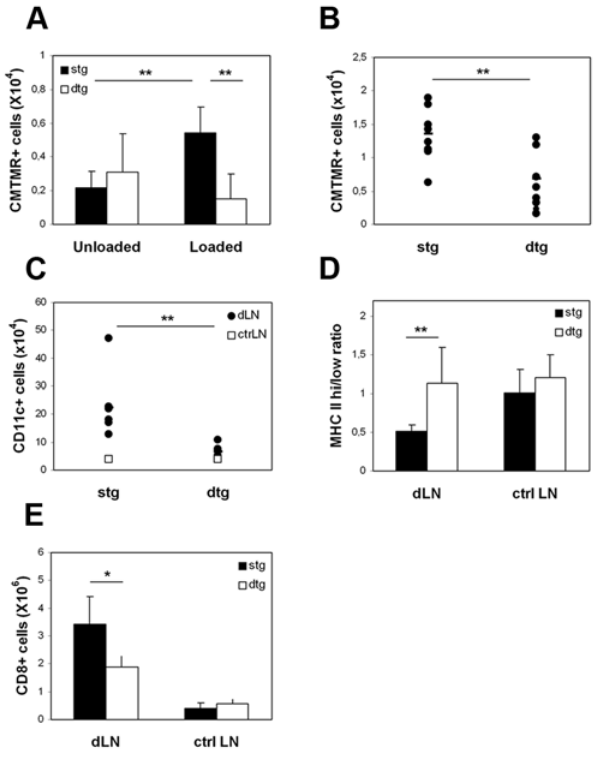
Figure 2. Effects of Tregs on DC migration towards dLNs. DCs were stained with CMTMR, loaded or not with HA peptide and injected into the footpads of stg or dtg mice. dLNs were harvested at day 1 (A) or day 2 (B–E) post-injection, collagenase-digested, and analysed by flow cytometry to determine absolute numbers of CMTMR + , transferred (A, B) and CMTMR 2 CD11c + , endogenous (C) DCs, the ratio of MHC class II high/low CD11c + cells (D) and the absolute numbers of CD8 + cells (E). The figures shown correspond to pooled data from three independent experiments; in each experiment two to four mice per group were used.